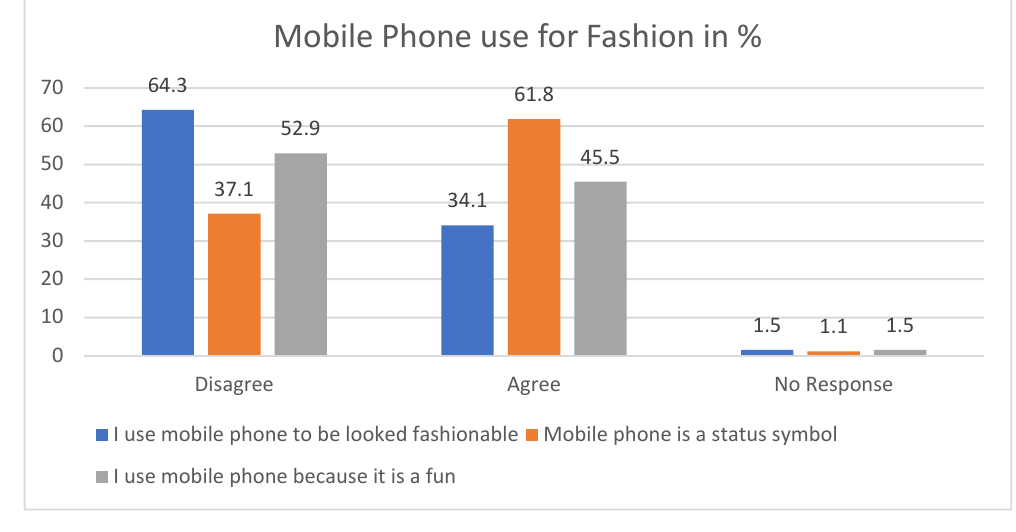
Figure 4. Mobile phone as a fashion symbol among young people. Table 4. T -test for mobile phone use for fashion gender-wise.